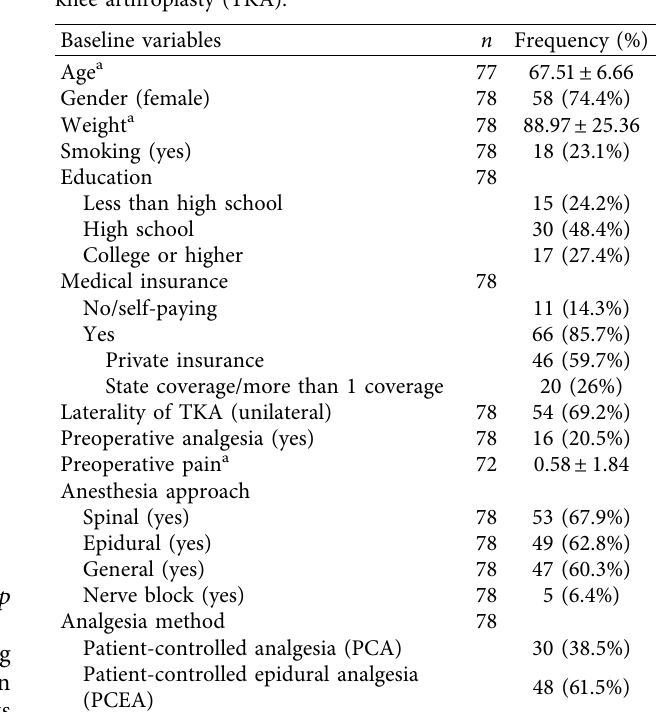
Table 1: The baseline variables of the patients who underwent total knee arthroplasty (TKA).